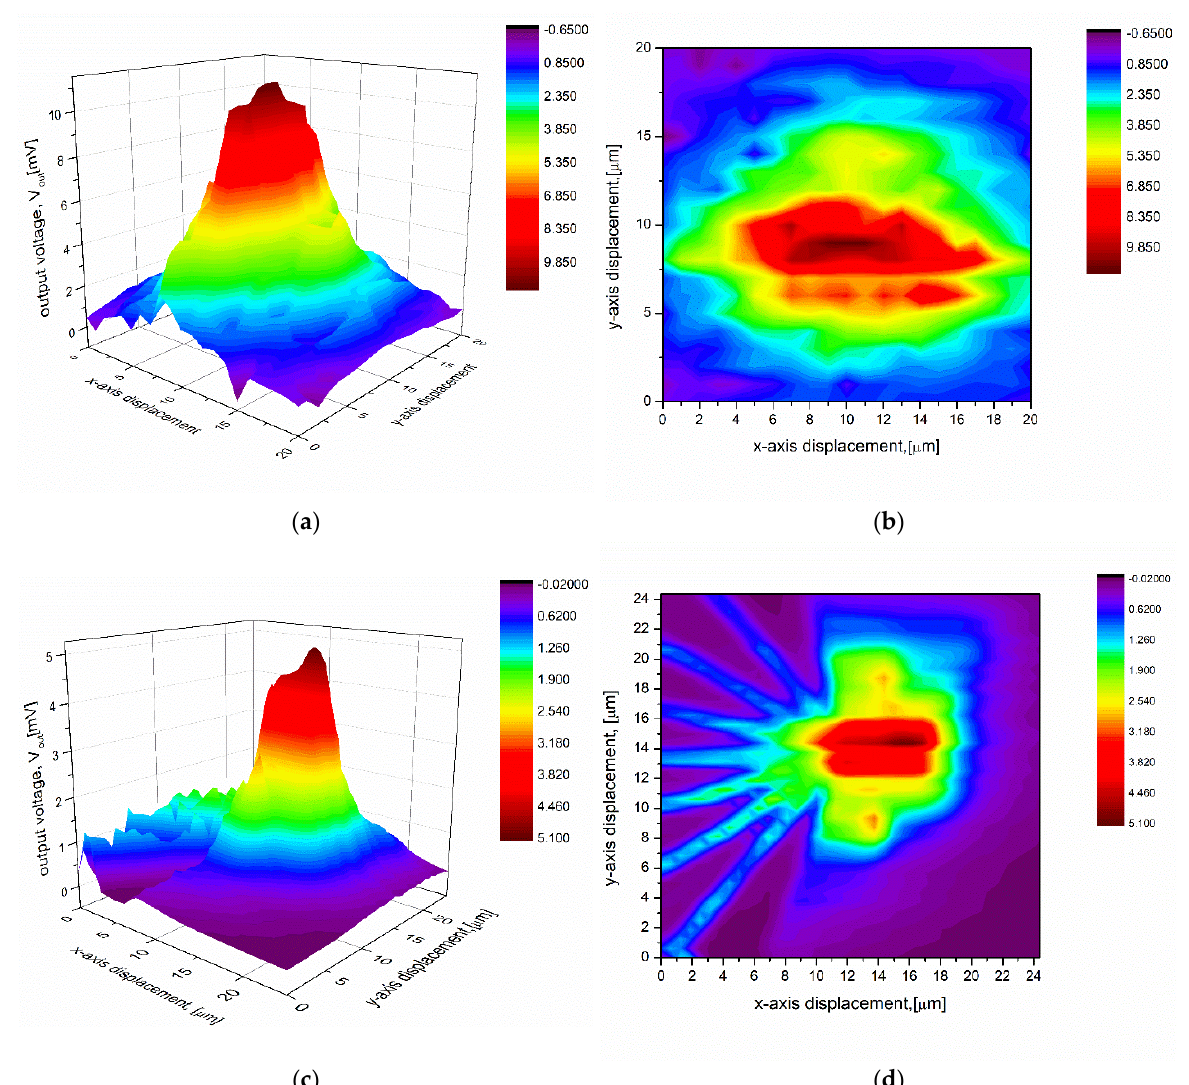
Figure 5. Measured thermoelectric voltages confirming the Gaussian distribution of the incident light intensity obtained using a single thermocouple with ( a ) the microscale hot junctions (shown in Figure 3a), and ( c ) the nanoscale hot junctions (shown in Figure 3b), displaced in the plane of the light spot; ( b – d ) top view of 3D graphs ( a ) and ( c ).